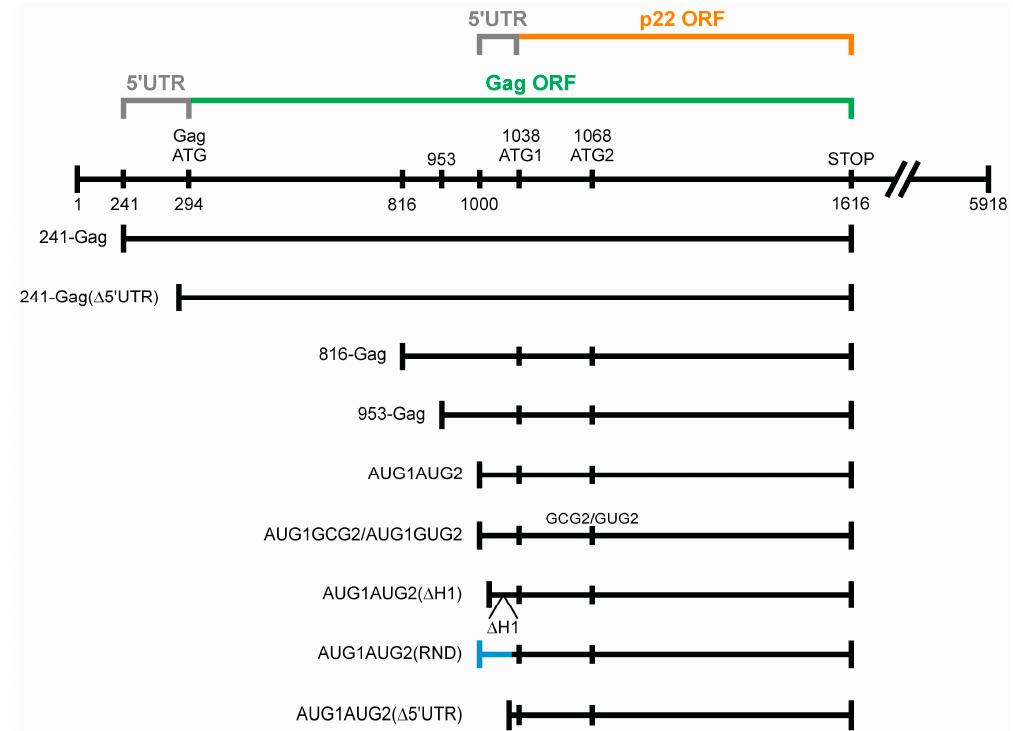
Figure 1. RNA constructs used in this study. Nucleotide positions correspond to the Ty1H3 DNA sequence (GenBank accession M18706.1) [15]. 5’ UTR: 5’ untranslated region, ORF: open reading frame.